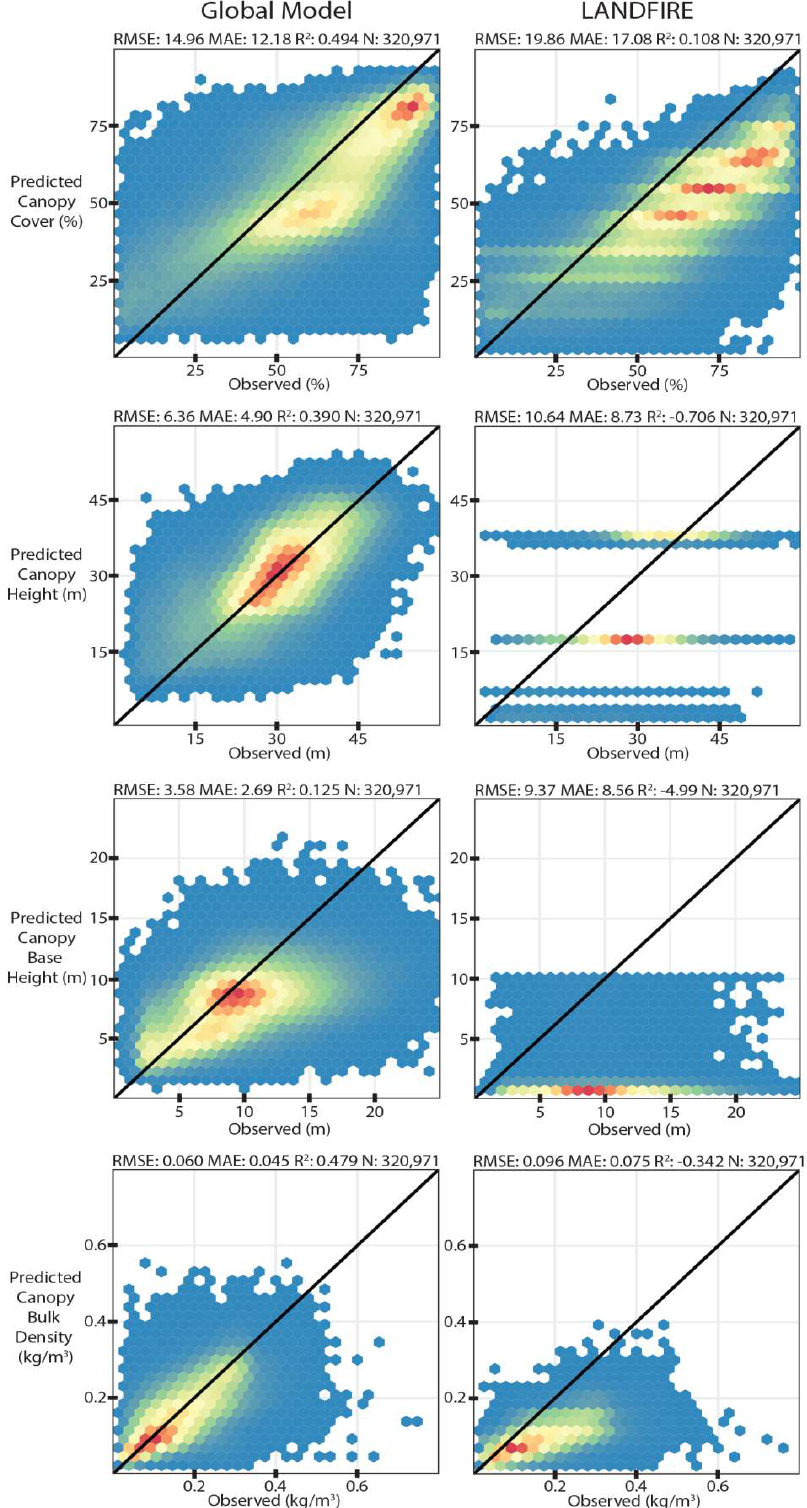
Figure 9. Predicted versus observed plots for the Slate Creek test landscape using the global GBM model ( left column ) and existing LANDFIRE layers ( right column ). Point density indicated with blue ( low ) to red ( high ) gradient.